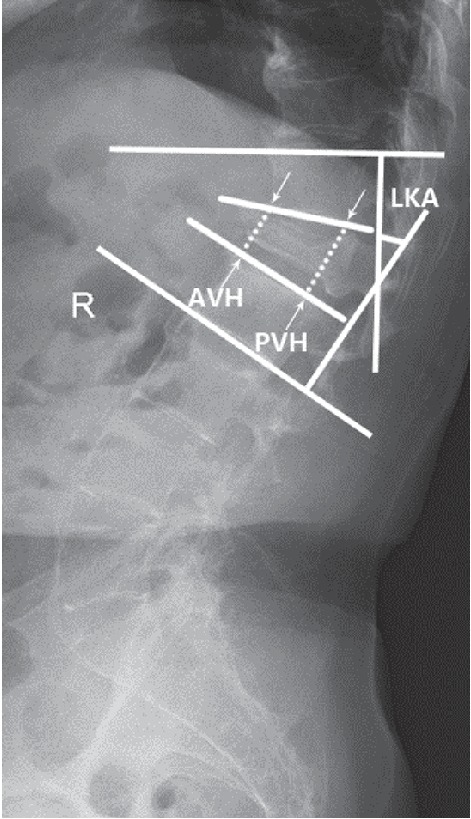
The degree of local kyphotic angle (LKA) was measured from the upper endplate of the instrumented vertebra to the lower endplate of the instrumented vertebra below the fractured level. The anterior vertebral height (AVH) and posterior vertebral height (PVH) were measured as the distance between the upper and lower endplates at the anterior wall and posterior wall of the vertebral body, respectively.